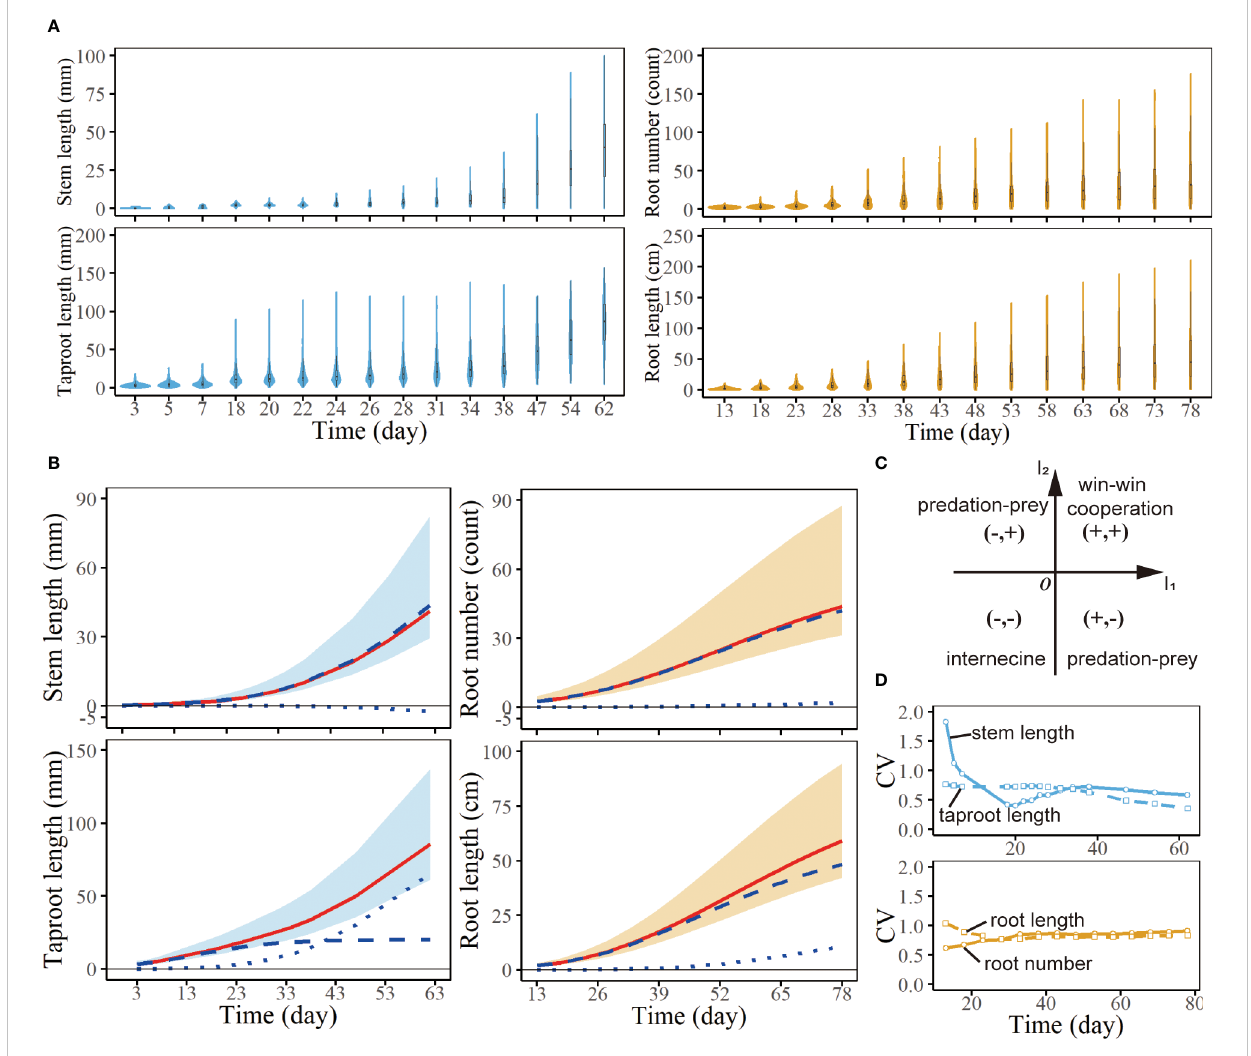
FIGURE 2 Analysis of the growth of seedlings from a full-sib family of Populus euphratica . (A) Violin plots of stem length, taproot length, root number and root length of all samples at a series of times. (B) Growth curves of stem length, taproot length, root number and root length. Each red line is the fi tting curve of average growth for corresponding trait, which consists of independent growth (broke lines) and interactive growth with another trait (dot lines). (C) Strategic coordinate system of interaction types between two traits. According to the sign of ( I 1 , I 2 ), the strategy plane is divided into four regions, representing four interaction types between traits. (D) CV curves of stem length, taproot length, root number and root length of all samples at a series of